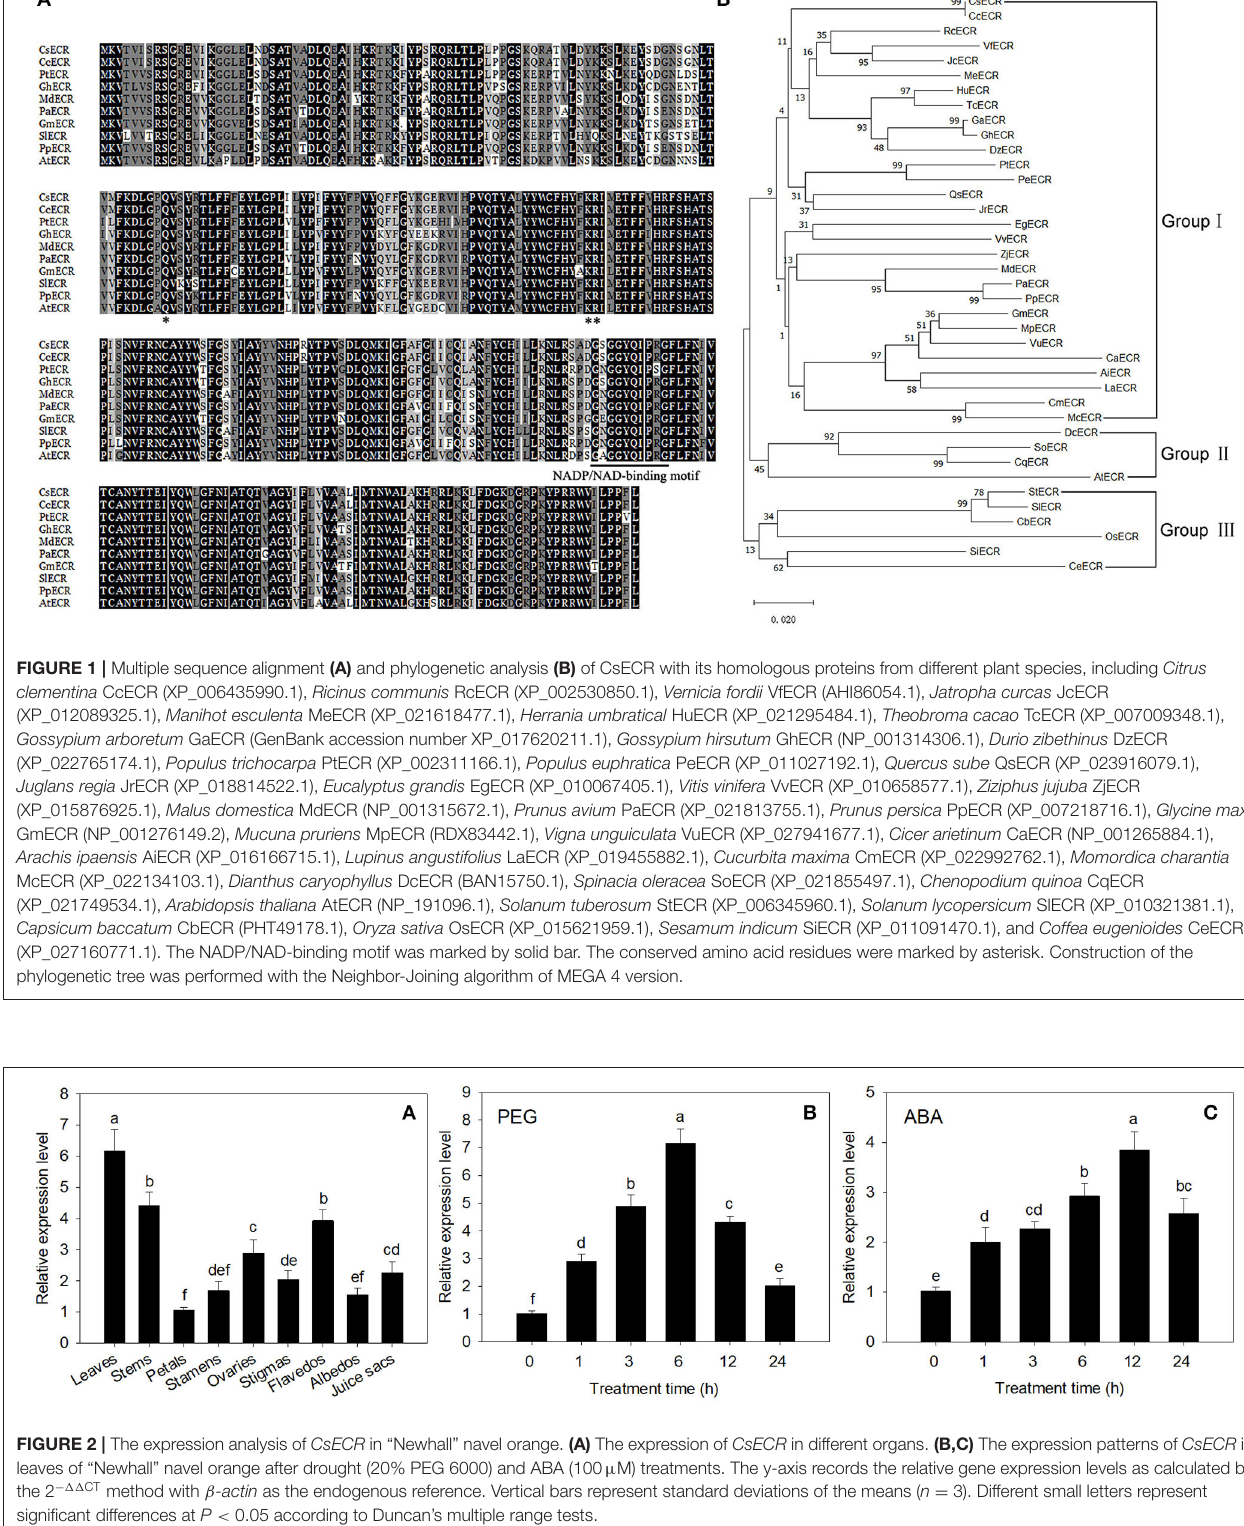
Frontiers in Plant Science |